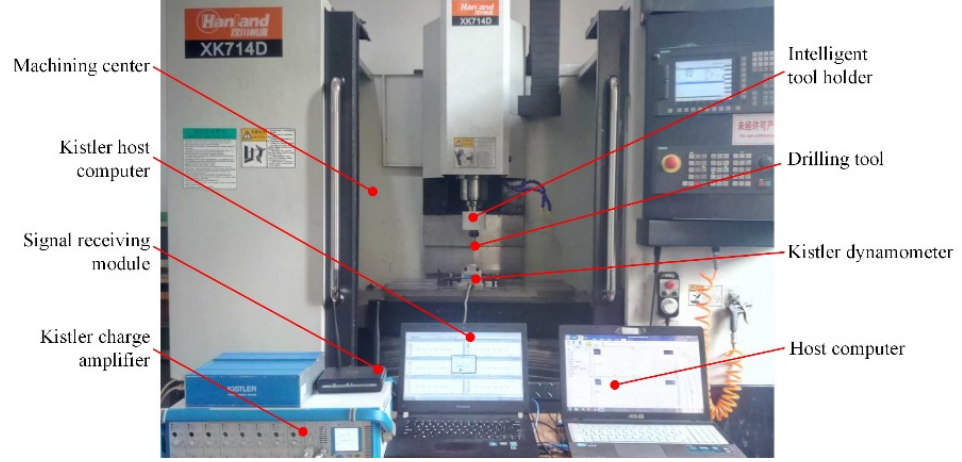
Figure 7. Photograph of the cutting experiment.